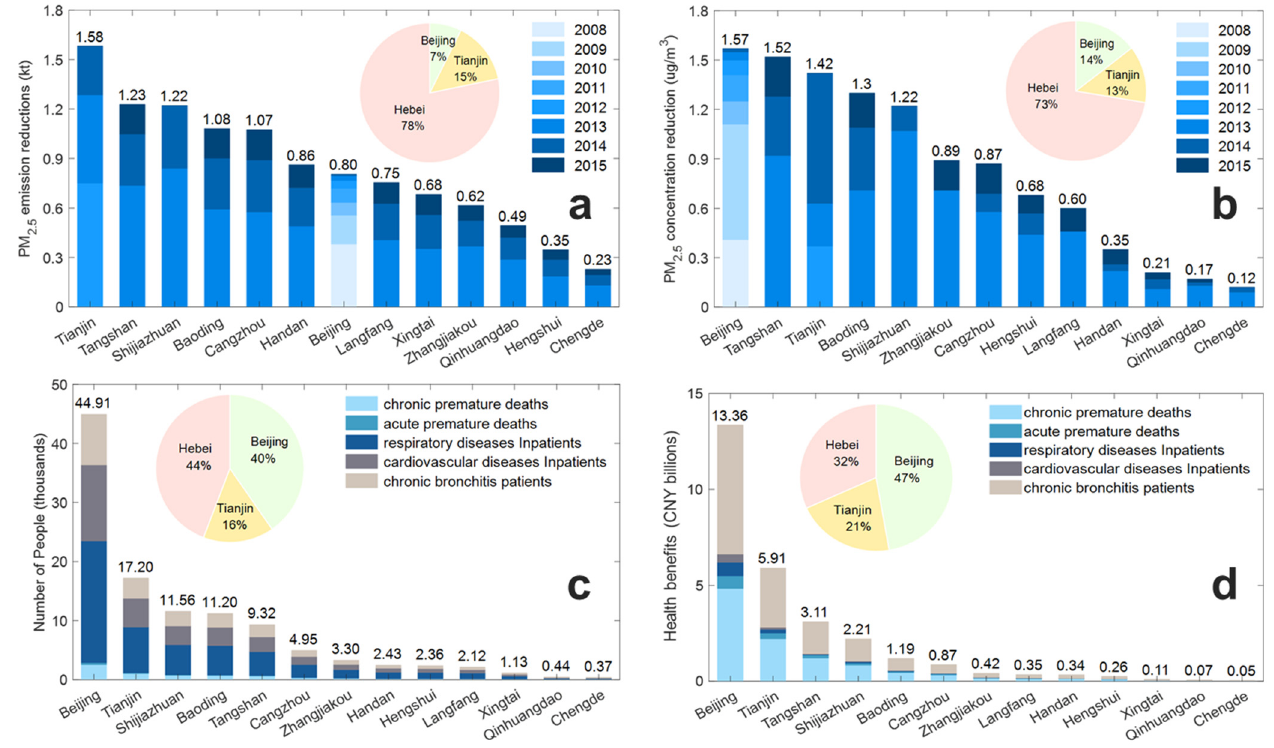
Figure 5. PM 2.5 emission reductions ( a ), PM 2.5 concentration reduction ( b ), number of people at the health endpoints ( c ), and health benefits ( d ) due to the implementation of the HEV driving area restriction policy.